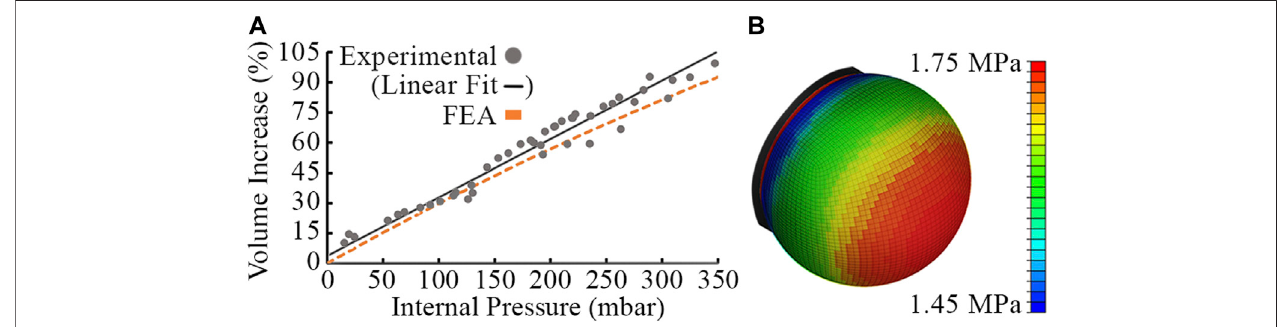
FIGURE 4 | Experimental data points, linear fi t of experimental data and FEA model using Abaqus for a 1 mm thick DragonSkin 30 membrane. (A) Volumetric expansionagainst pressurepredictedbytheFEAmodel andfoundexperimentallyfromthemanufacturedmembrane. (B) FEAdeformedmeshand stressdistribution at 100% in fl ation.